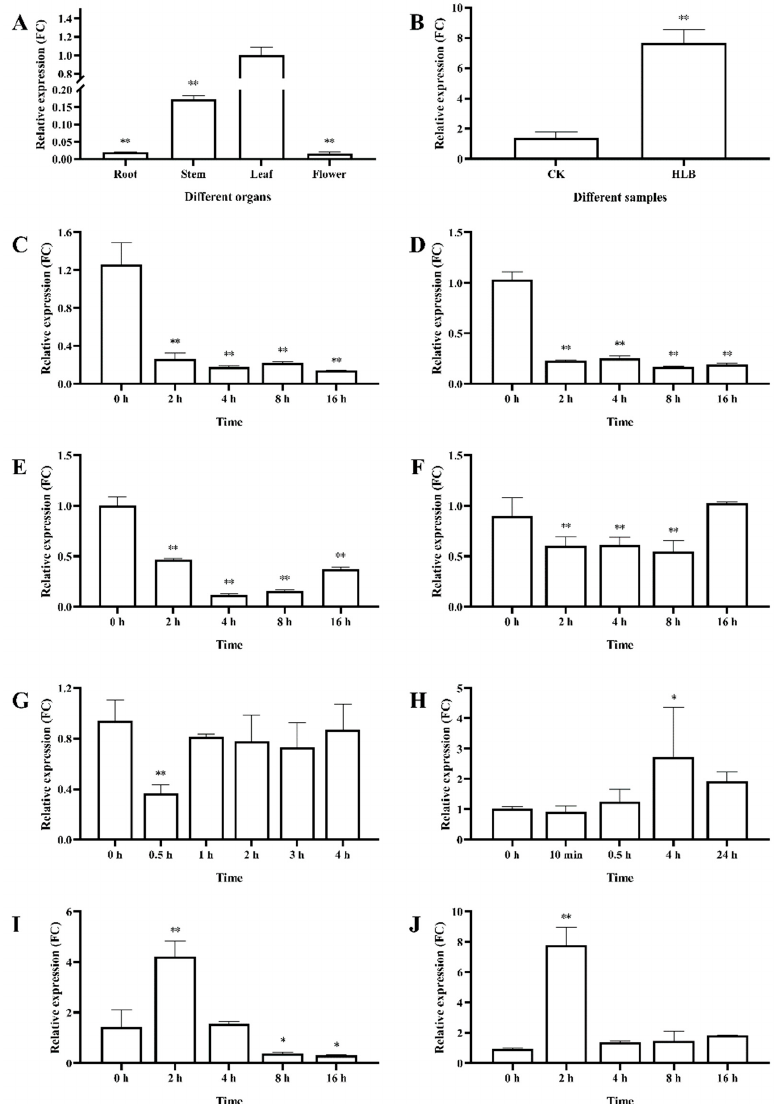
Figure 4. Expression levels of RIN4 in different organs ( A ), in leaves of HLB infected citrus ( B ) and in leaves under different treatments ( C – J ). FC: fold change; ( A ): Different organs; ( B ): RIN4 expression in leaves of healthy and HLB infected citrus; ( C ): GA treatment; ( D ): IAA treatment; ( E ): JA treatment; ( F ): SA treatment; ( G ): PEG treatment; ( H ): Wound treatment; ( I ): Salt treatment; ( J ):